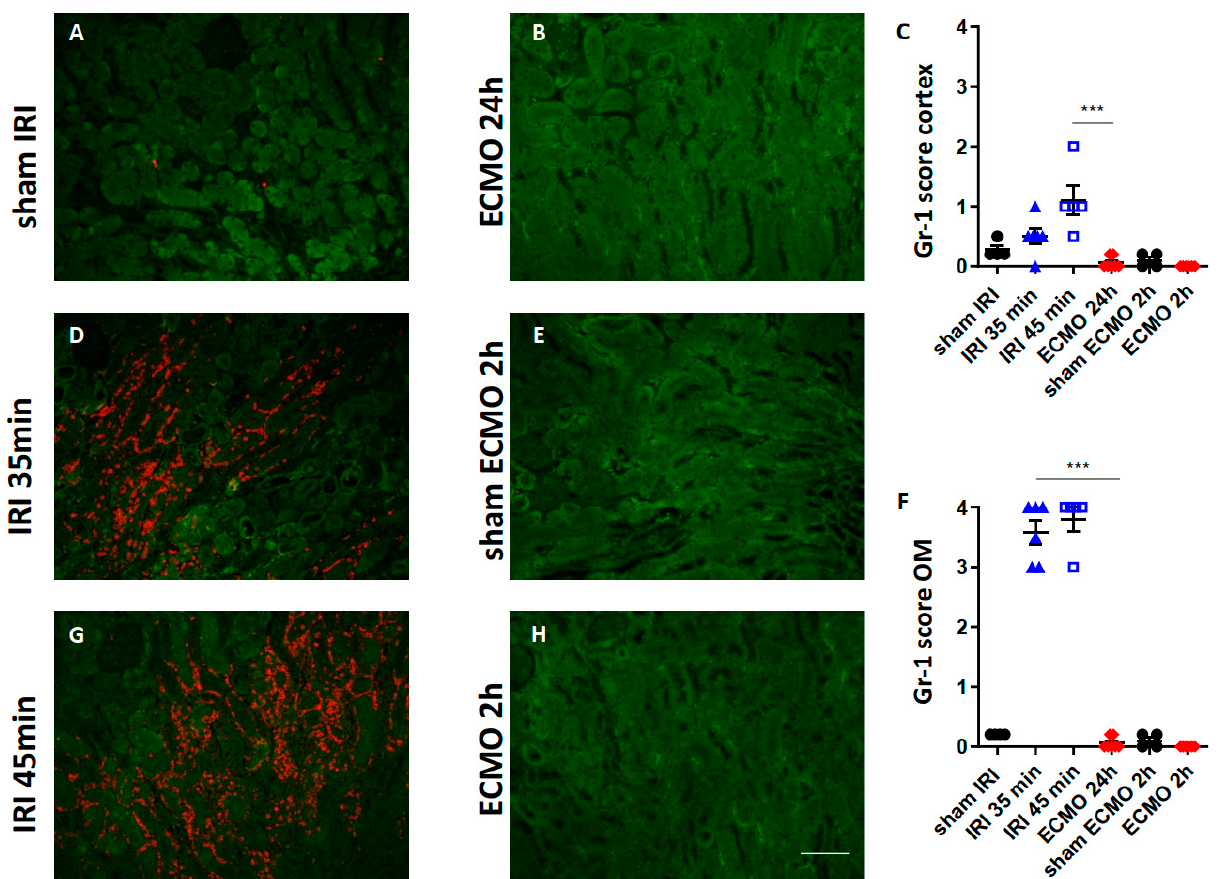
Figure 2. Neutrophil infiltration of the kidney after moderate and severe renal IRI and after ECMO. Gr-1-stained kidney sections of mice 24 h after moderate ( D ) and severe ( G ) renal IRI and 2 h ( H ) and 24 h ( B ) after ECMO are shown. The Gr-1 staining signal is shown in red, tubular autofluorescence in green. Sham-IRI mice and sham-ECMO mice served as controls ( A , E ). Semi-quantitative scoring of Gr-1 expression is shown for the renal cortex in ( C ) and for the outer medulla (OM) in ( F ). Moderate and severe renal IRI caused marked infiltration of the ischemic kidney with neutrophils (orange signal, ( D , G )) whereas no major renal neutrophil infiltration 2 h ( H ) or 24 h ( B ) after ECMO was observed. N = 4–7 mice each group are shown. *** p < 0.001. Scale bar 100 µm.